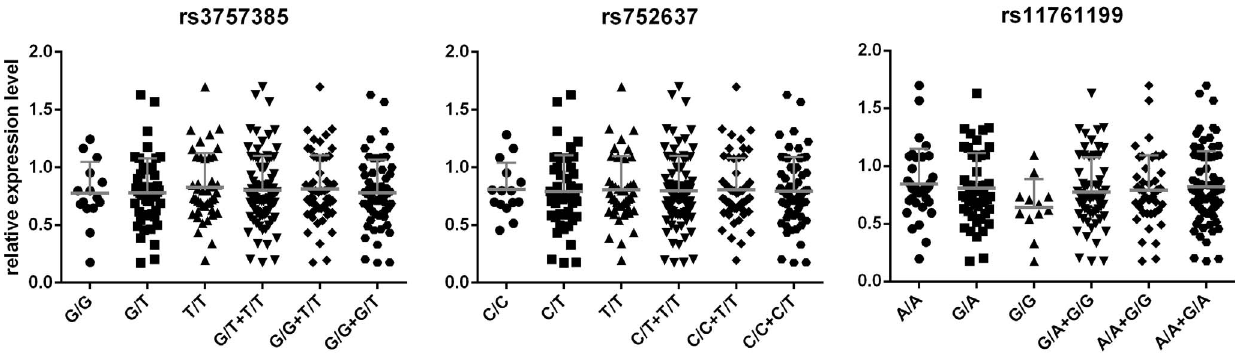
Figure 3. mRNA expression level of IRF5 in PBMC. We performed real-time qPCR to detect the mRNA expression of IRF5 in the PBMC of a total of 104 recipients, of whom the rejection had not been observed within 6 months post-operation.